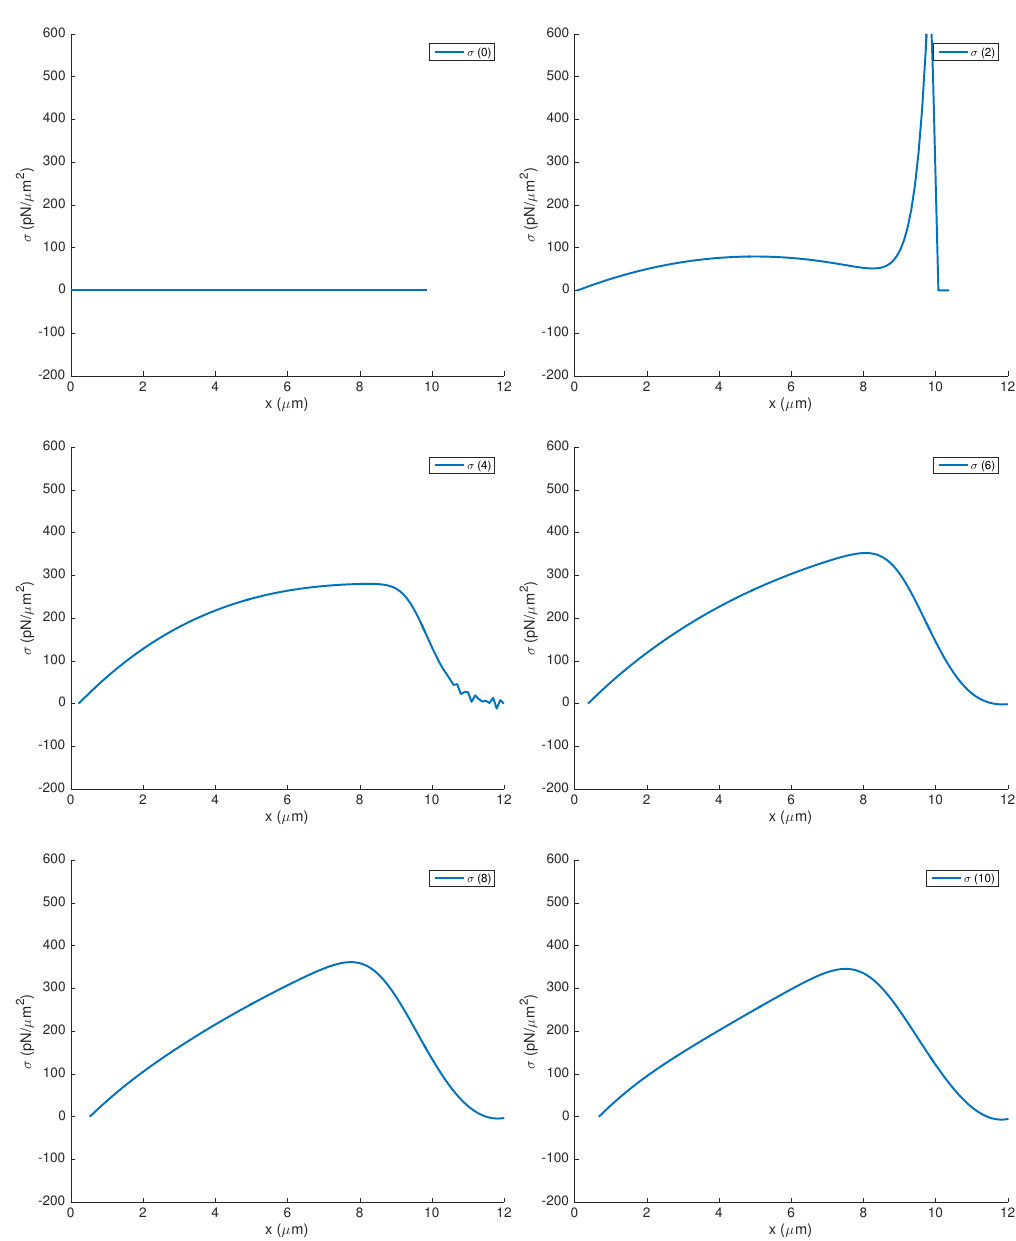
Figure 6. Stresses undergone by the cell body during 10 s of simulation. The deformation of the cell body with time is also